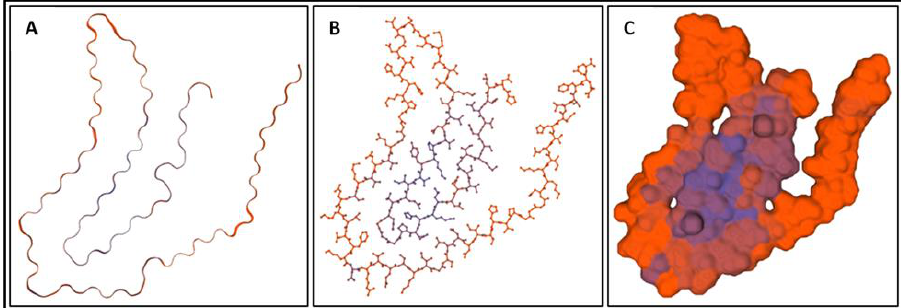
Figure 5. ( A ) A cartoon model, ( B ) a ball-and-stick model, and ( C ) a surface model of NF-L [30].